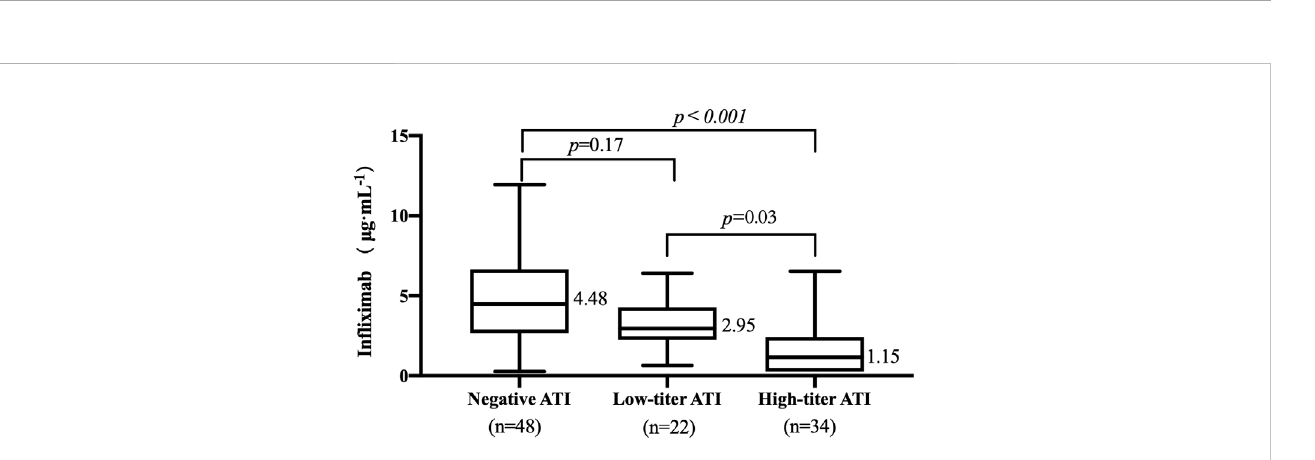
FIGURE 2 Relationship between trough levels ofin fl iximab(TLI) andantibodiestoin fl iximab (ATI)titer.ATI titers of1:20 and ≥ 1:60wereconsideredalow titeranda high titer, respectively.